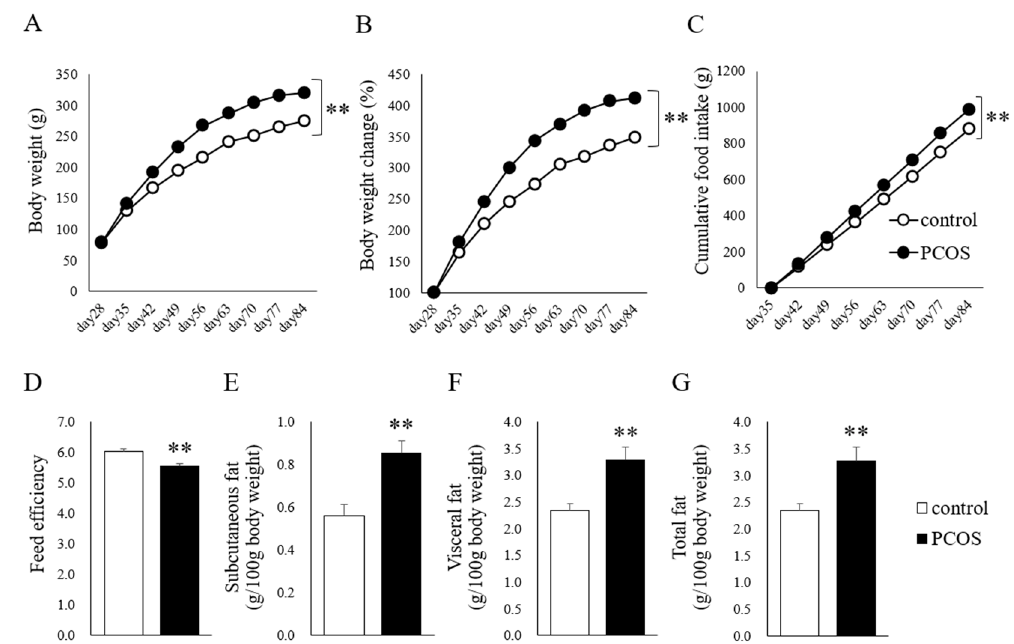
Figure 1. ( A ) Body weight, ( B ) body weight change (% initial body weight), ( C ) cumulative food intake, ( D ) feed efficiency, ( E ) subcutaneous fat weight (g/100 g body weight), ( F ) visceral fat weight (g/100 g body weight), and ( G ) total fat weight (g/100 g body weight) in the PCOS ( ■ ) and Control ( □ ) groups. Data are expressed as the means ± SEM. ** p < 0.01.